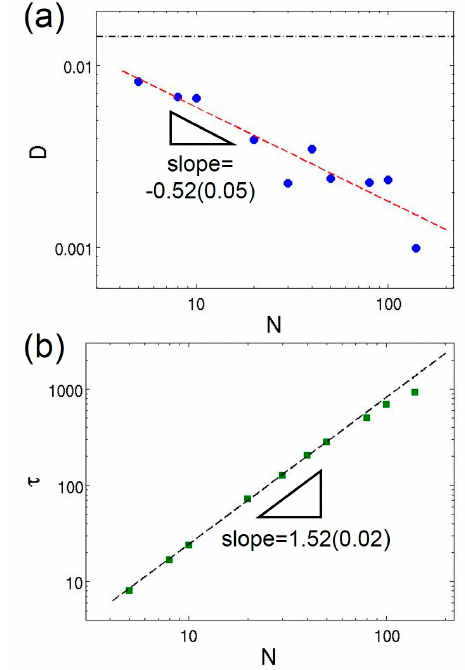
Figure 6. Log–log plots of: ( a ) the diffusion coefficient; and ( b ) the longest relaxation time as functions of chain length in the theta solvent. The black dash-dot line in ( a ) indicates the diffusion coefficient of the solvent beads. The dashed lines in ( a , b ) represent the power-law fittings of the data. The error bars are smaller than the symbols.